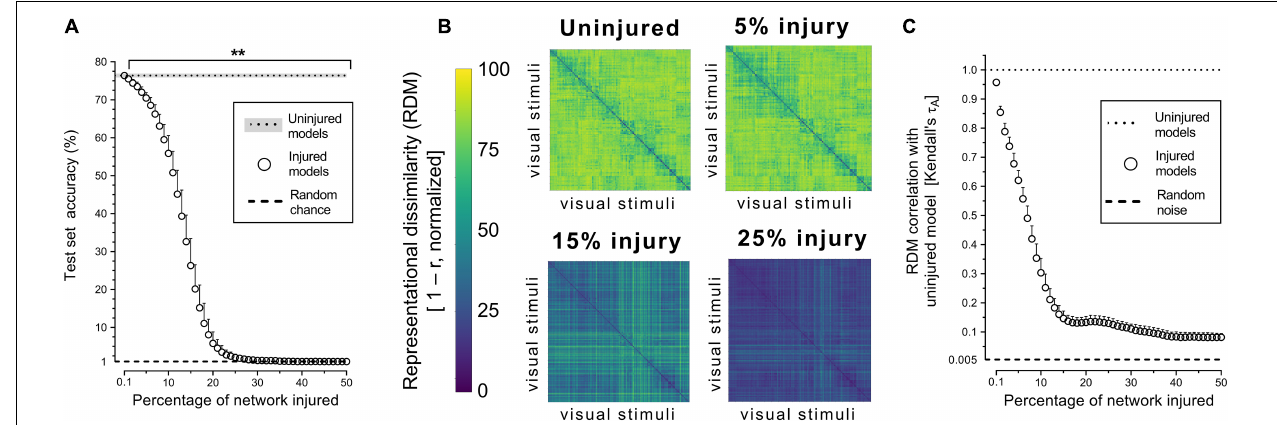
FIGURE 2 | Trained VGG-19 networks underwent progressive neurodegeneration. (A) Object recognition performance of injured VGG-19 models on the CIFAR-100 dataset with simulated PCA. (B) Internal activity of artificial neurons in the model’s penultimate layer visualized with representational similarity analysis. The RDMs visualized are the average of the 25 trained networks. (C) Changes in internal activity patterns relative to uninjured control models measured using Kendall’s τ A correlation coefficient. Data are shown as mean + SD, n = 25 models, ** P < 0.01 with one-way repeated measures ANOVA with Bonferroni’s correction for multiple